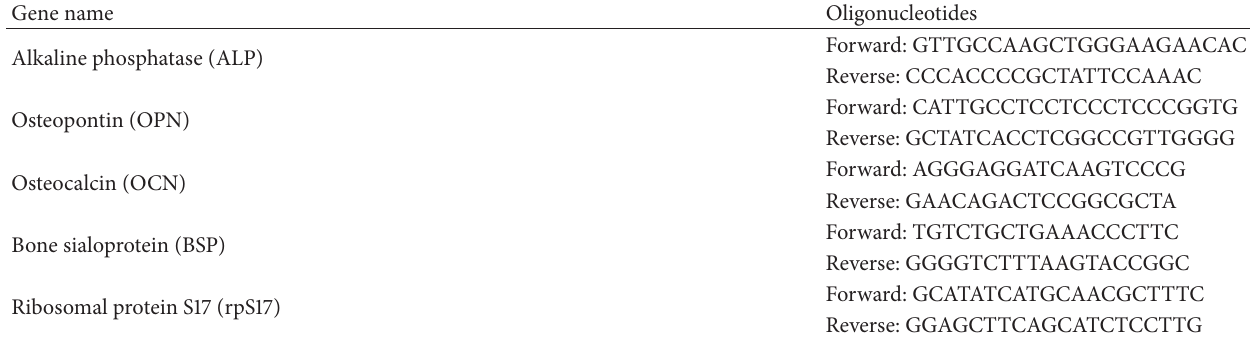
Table 2: Primers designed for RT-PCR analyses of gene related to calcification.